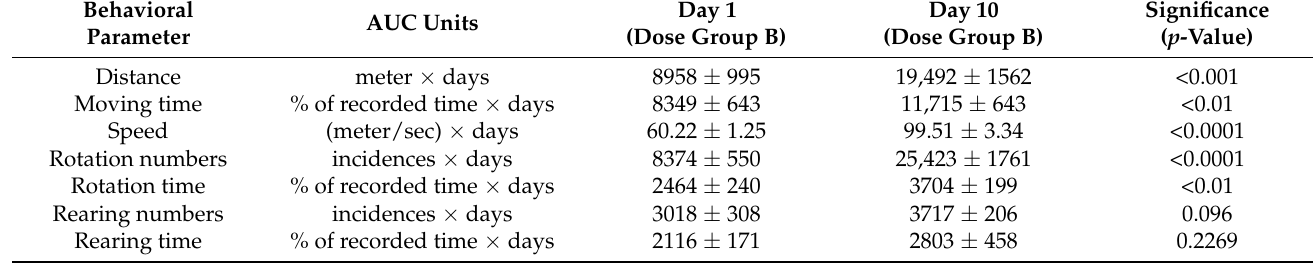
the differences in their area under the curves (AUC) in Table 1, which indicates that differences were observed in the distance, moving time, and speed.